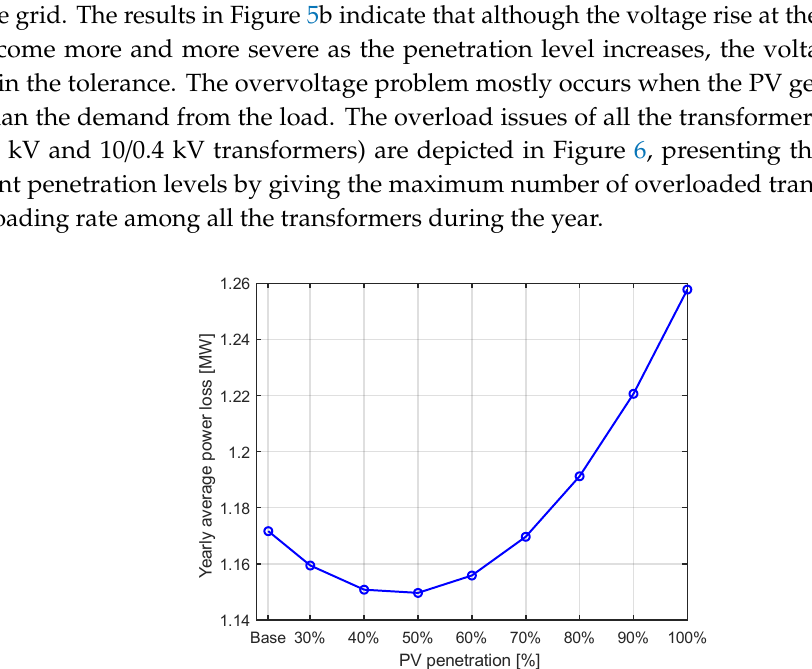
Figure 4. The yearly average power loss of the entire grid at different PV penetration levels (with PF ( P )).